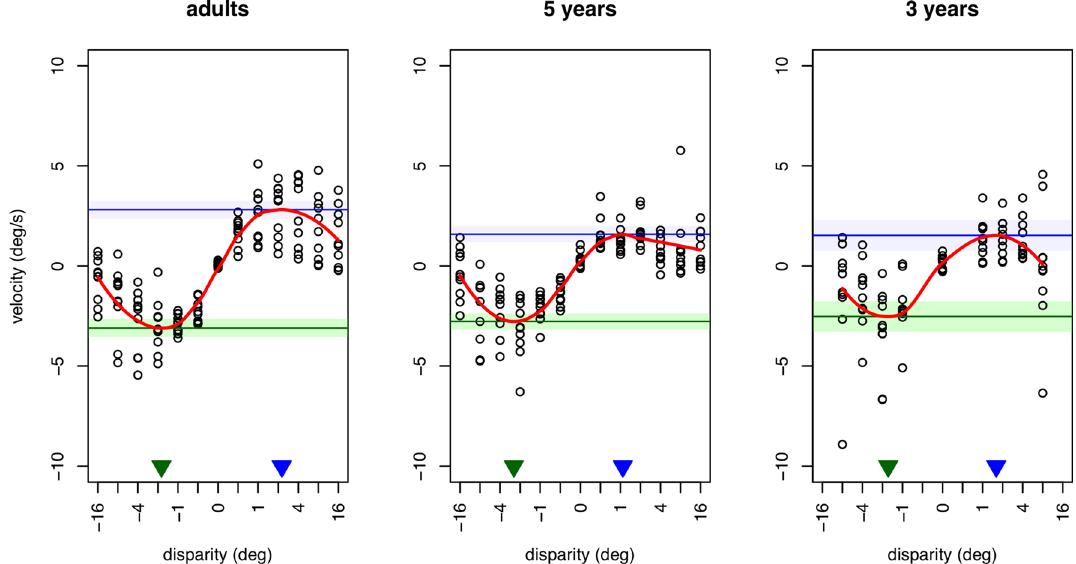
Figure 4. The velocity estimates from the averaged vergence responses collected from each participant in each age group (open circles; n = 10 per group). The curves fit to these data are LOESS functions. The horizontal green (lower) and blue (upper) lines indicate the peaks for the convergent and divergent responses, respectively, with the 95% confidence interval for these peak estimates (shaded region). Triangles indicate the stimulus disparity at these peak